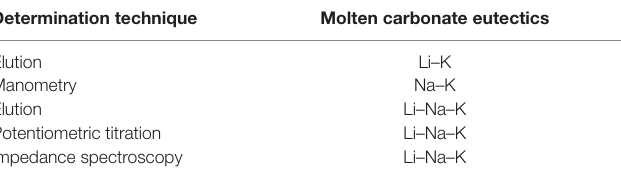
TABLe 1 | Solubility of CO 2 in molten carbonates. Determination technique Molten carbonate